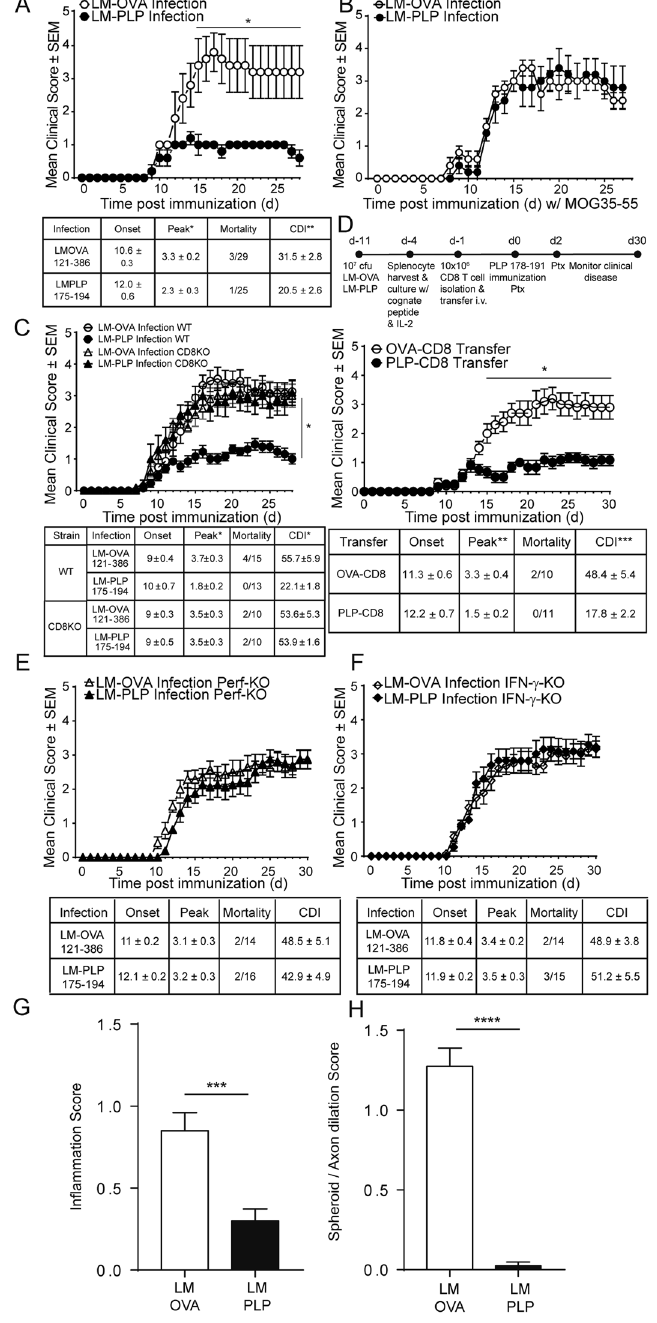
Figure 2. LM-PLP infection protects mice from EAE in a CD8-dependent antigen-specific manner. ( A ) B6 mice were infected with LM-PLP or LM-OVA on d-7 and immunized with PLP178-191/CFA on d0 and monitored for clinical disease. ( B ) B6 mice were infected with LM-PLP or LM-OVA, followed by induction of EAE with non-cognate antigen MOG35-55/CFA. Disease scores are shown. ( C ) CD8-KO mice were infected with either LM-PLP or LM-OVA on d-7, immunized with PLP178-191/CFA on d0 and monitored for clinical disease. ( D ) CD8 T cells harvested from LM-PLP or LM-OVA-infected B6 mice were stimulated in vitro with PLP178-191 and OVA257-264 respectively, and adoptively transferred into naïve recipients followed by subsequent immunization with PLP178-191/CFA and the monitoring of clinical disease. ( E ) Perf-KO mice were infected with LM-PLP or LM-OVA on d-7, immunized with PLP178-191/CFA on d0, and monitored for clinical disease. ( F ) IFN- γ -KO mice were infected with LM-PLP or LM-OVA on d-7, immunized with PLP178-191/CFA on d0, and monitored for clinical disease as depicted. ( G ) Inflammation and ( H ) Spheroid/ axon dilation scores from H&E stained lumbar spinal cord sections from infected and immunized mice on d18 post-immunization. Data are representative of at least two independent experiments in each panel. * p < 0.05, ** p < 0.01, *** p < 0.001 **** p <